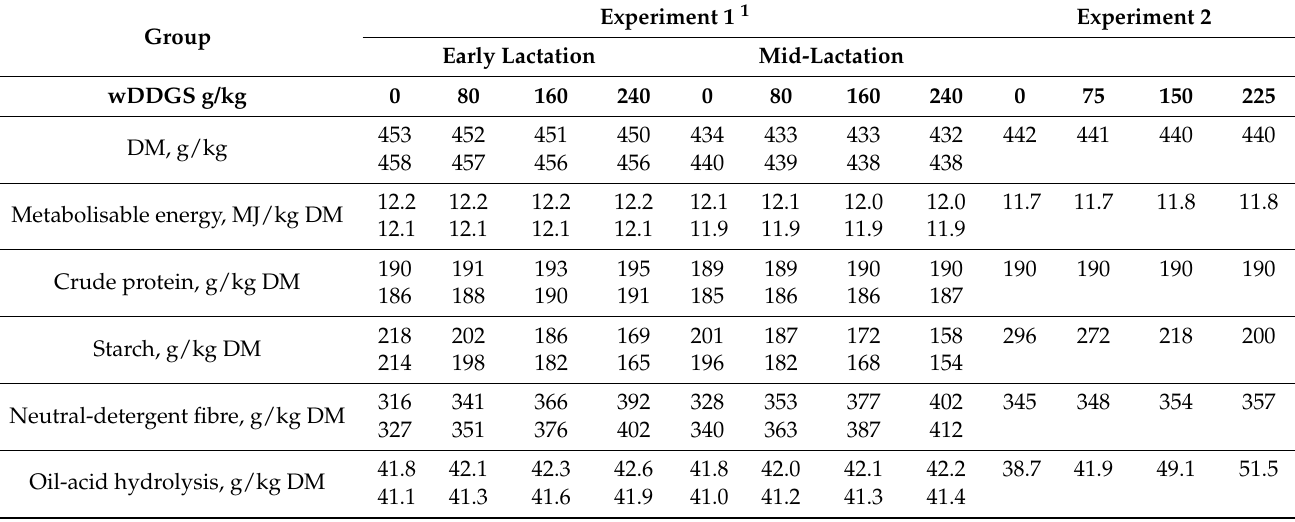
Table 2. Chemical composition of partial-mixed rations containing four levels of wheat-based dried distillers’ grains with solubles